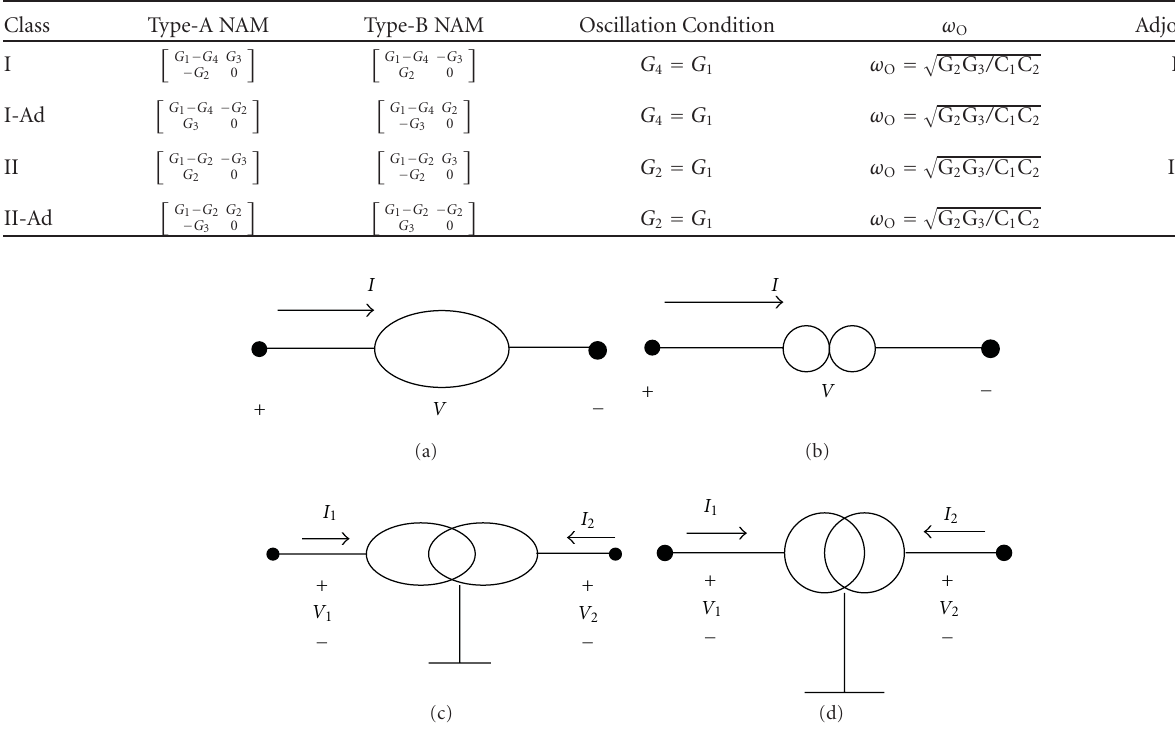
Figure 1: The pathological elements: (a) nullator, (b) norator, (c) voltage mirror, (d) current mirror.